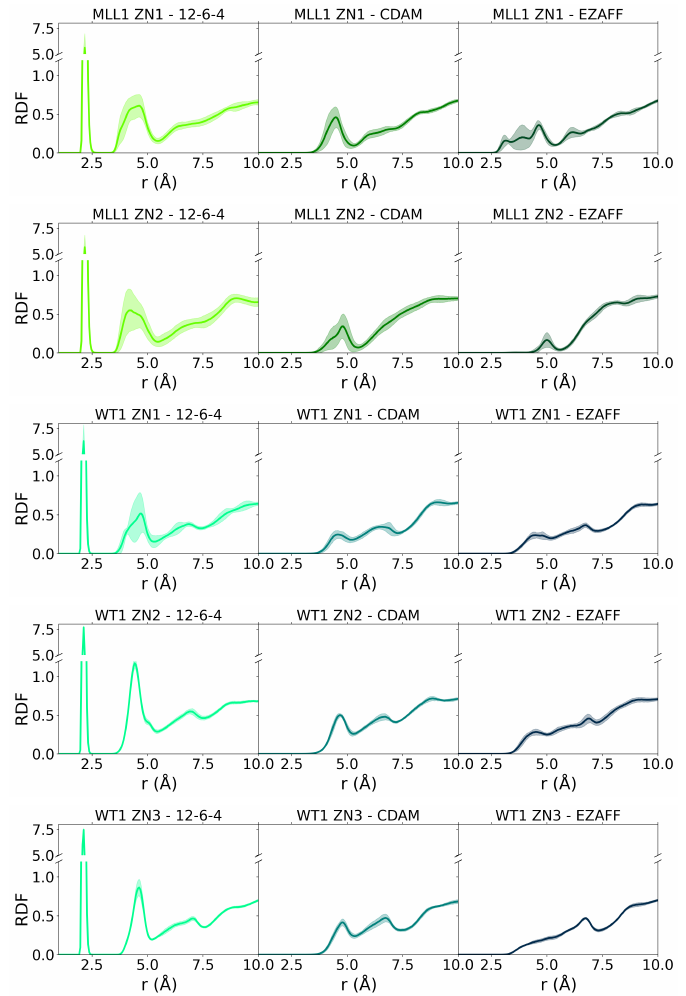
Figure 8. Radial distribution function of oxygen atoms of water molecules around the different Zn 2 + -ions in MLL1 and WT1, respectively, for all ion models. Note the broken RDF